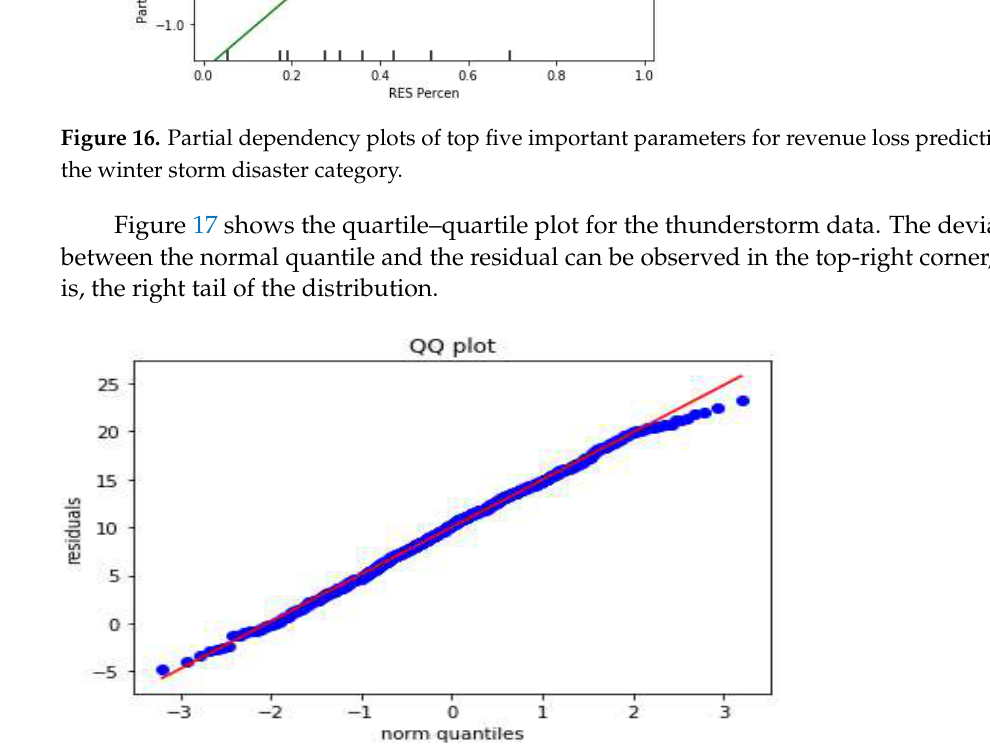
Figure 17. QQ plot (red line showing 45 degrees) shows data variability along the normal quantile distribution.